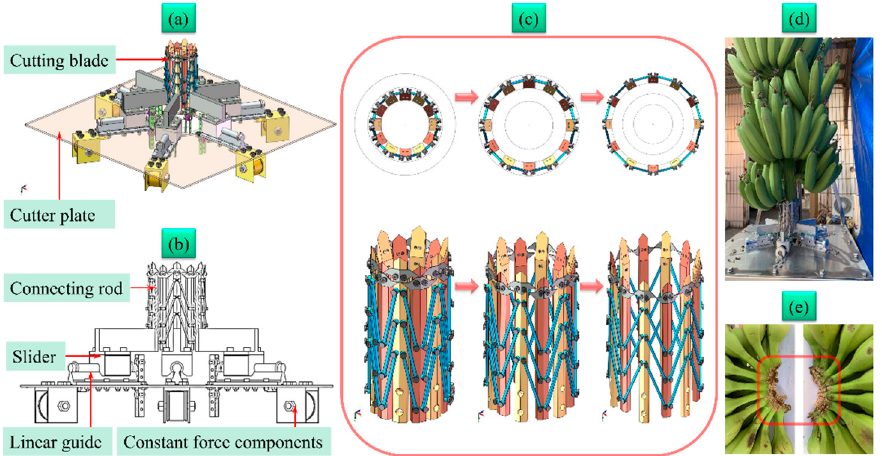
Figure 13. De-handing mechanism based on expandable mechanism. ( a ) Axonometric view of Figure 13. De ‐ handing mechanism based on expandable mechanism. ( a ) Axonometric view of de ‐ handing mechanism, ( b ) Front view of de ‐ handing mechanism, ( c ) Radial expanding process of cut ‐ de-handing mechanism, ( b ) Front view of de-handing mechanism, ( c ) Radial expanding process of ting blade group, ( d ) Schematic diagram of de ‐ handing experiment, ( e ) Incision of banana hands cutting blade group, ( d ) Schematic diagram of de-handing experiment, ( e ) Incision of banana hands after de ‐ handing. after